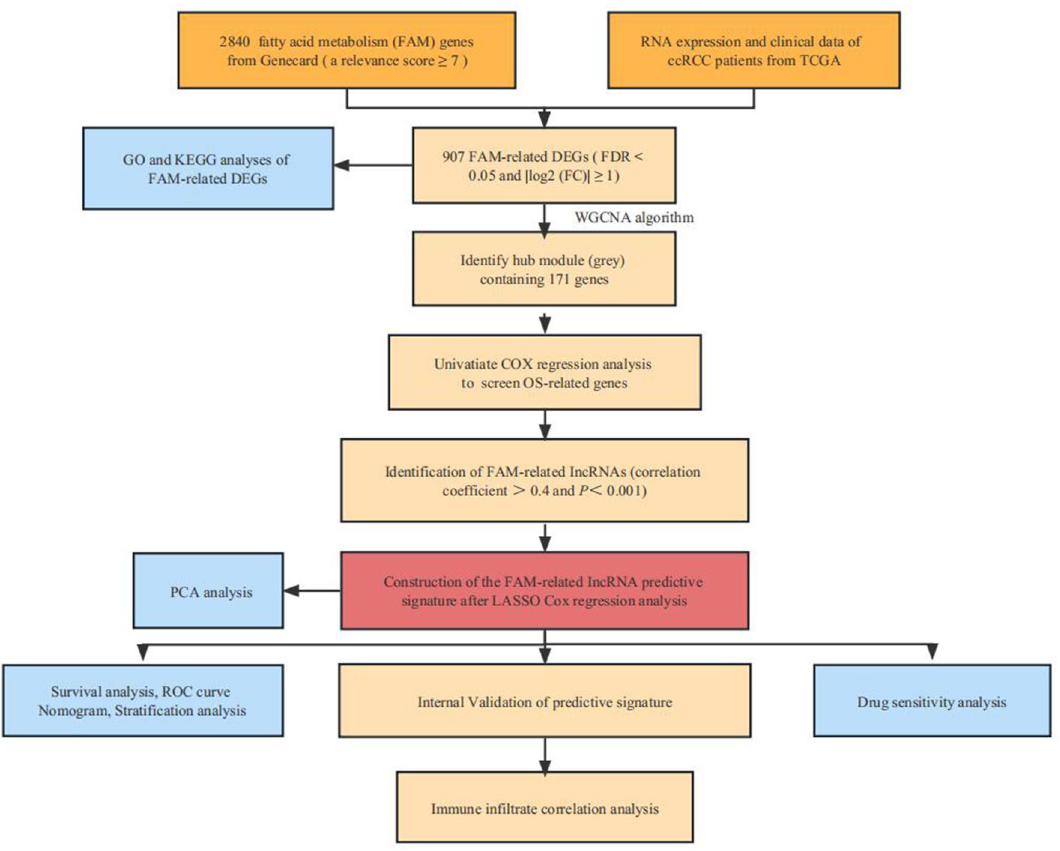
Figure 1. Flow chart of the study. ccRCC, renal clear cell carcinoma; TCGA, The Cancer Genome Atlas; DEGs, differentially expressed genes; GO, Gene Ontology; KEGG, Kyoto Encyclopedia of Genes and Genomes; lncRNAs, long noncoding RNAs; ROC, receiver operating